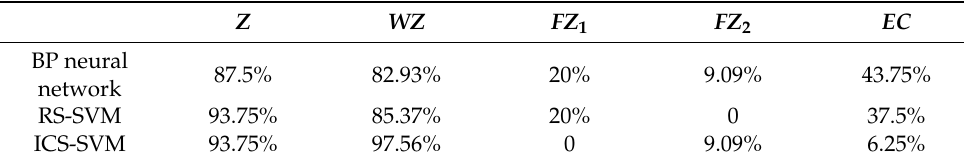
Table 4. The compared results of different